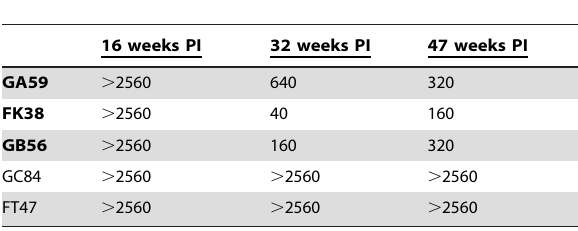
Table 2. Reciprocal end-point dilution titers of anti-C6 antibodies in antibiotic-treated* ( bold ) and untreated macaques infected with B. burgdorferi (Experiment